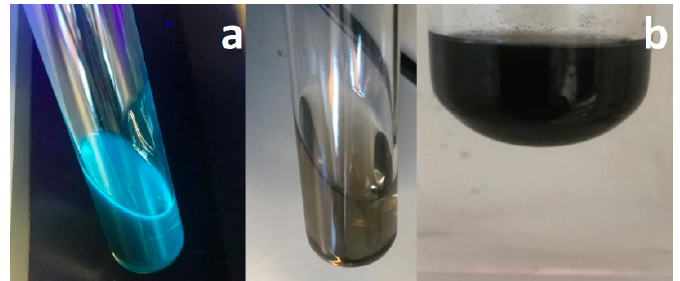
Figure 5. ( a ) Chloroform dispersion of TP9-PYR(6) and CNTs after centrifugation and recovery. On the left: sample under UV light (366 nm). On the right: the same dispersion without UV illumination. ( b ) Dispersion of TP9-PYR(6) and CNTs after 1 month in chloroform.